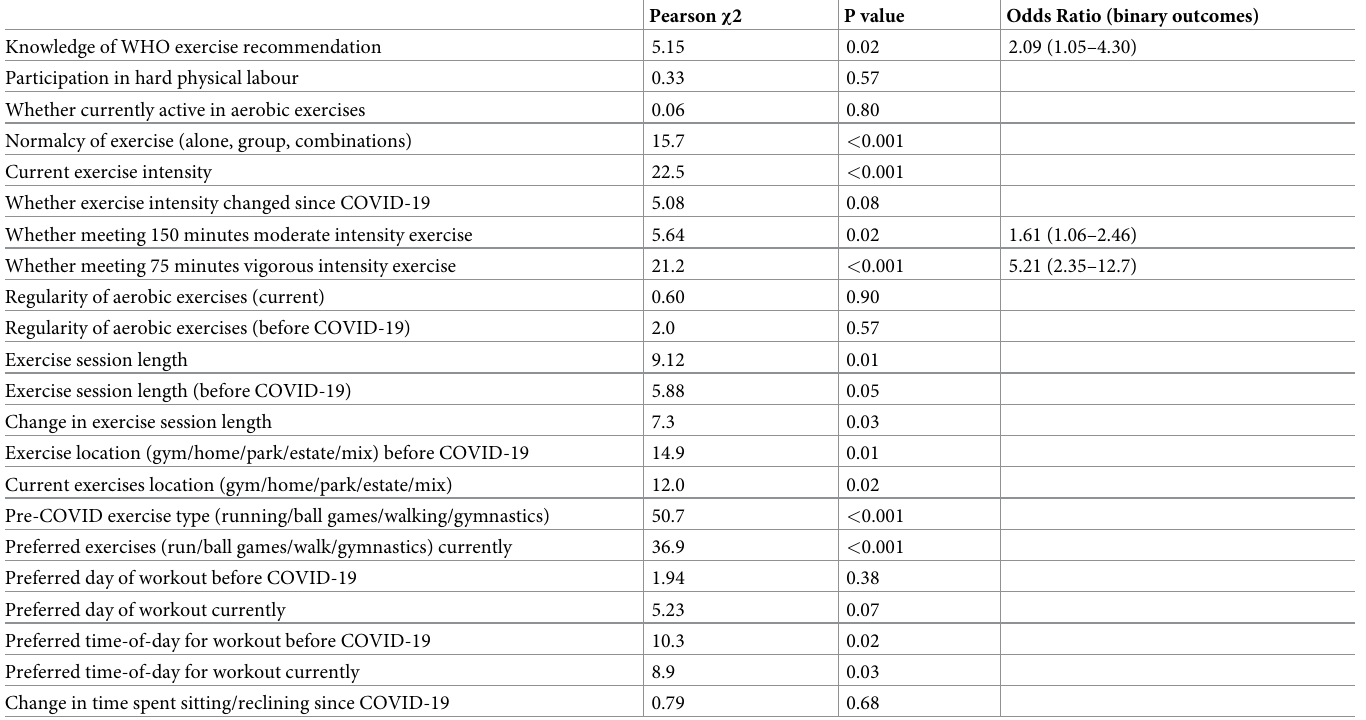
Table 5. Association between sex (reference, males) and various